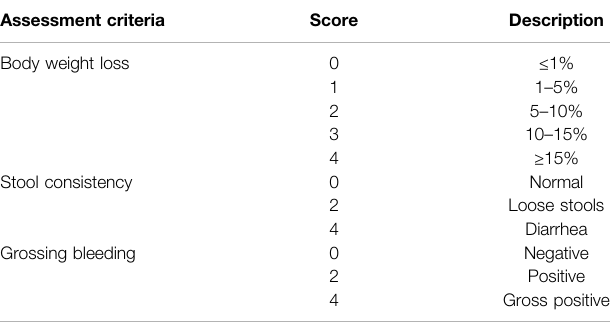
TABLE 1 | Disease Activity Index assessment criteria for dextran sodium sulfate- induced colitis